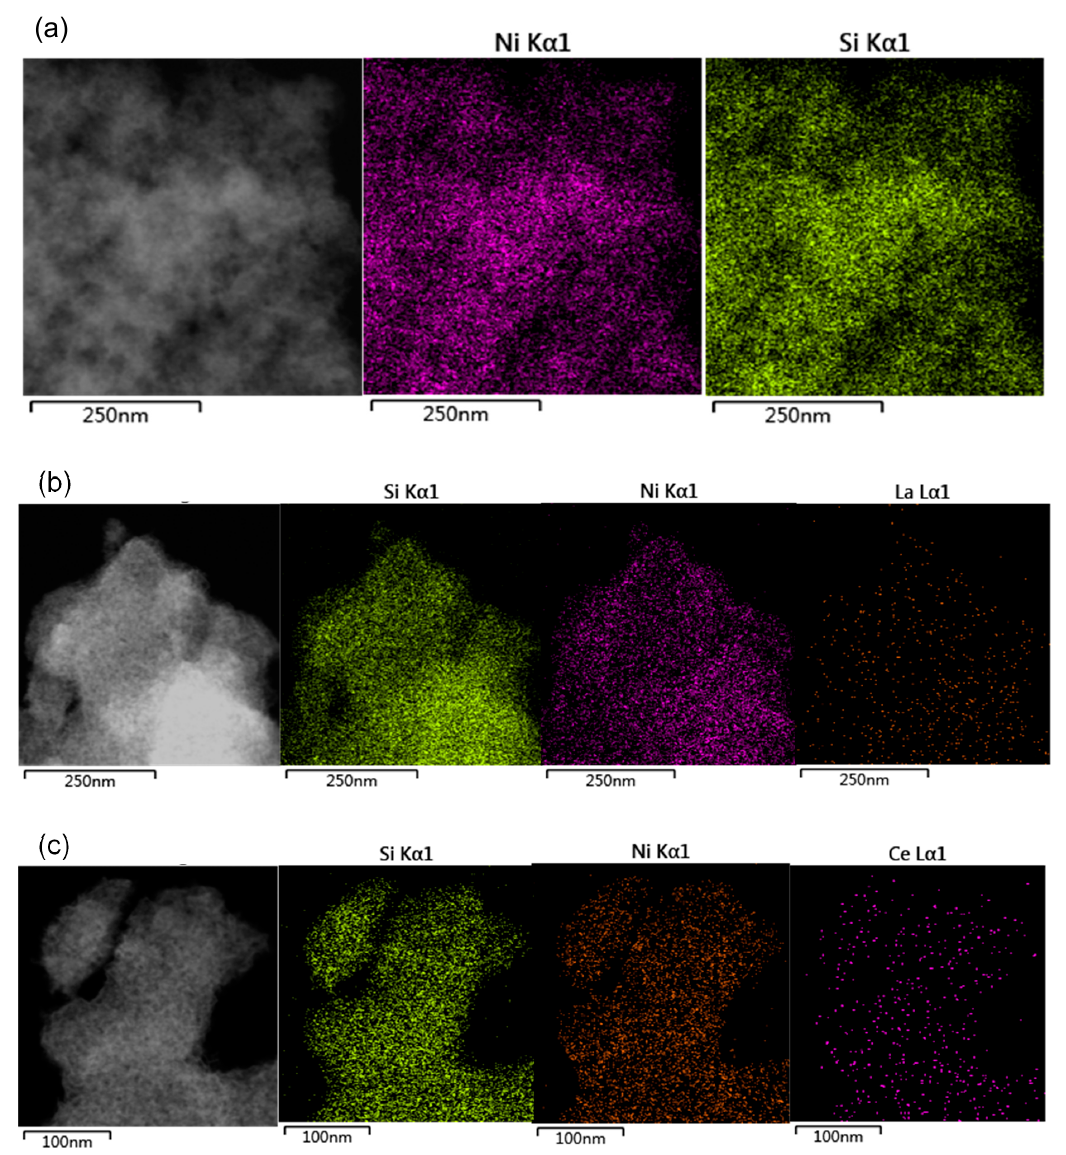
Figure 2. Transmission electron microscopy (TEM) images and energy0dispersive X-ray spectroscopy (EDS) elementary mapping images of Ni/MCM-41 ( a ), Ni-5La 2 O 3 /MCM-41 ( b ), and Ni-5CeO 2 /MCM-41 ( c